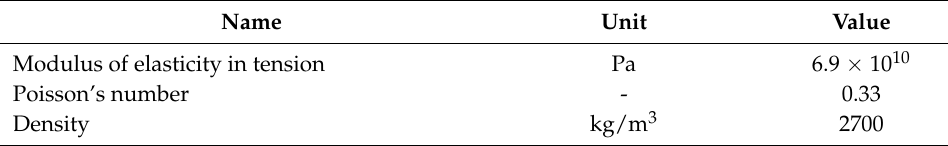
Table 2. The natural frequency of the frame.